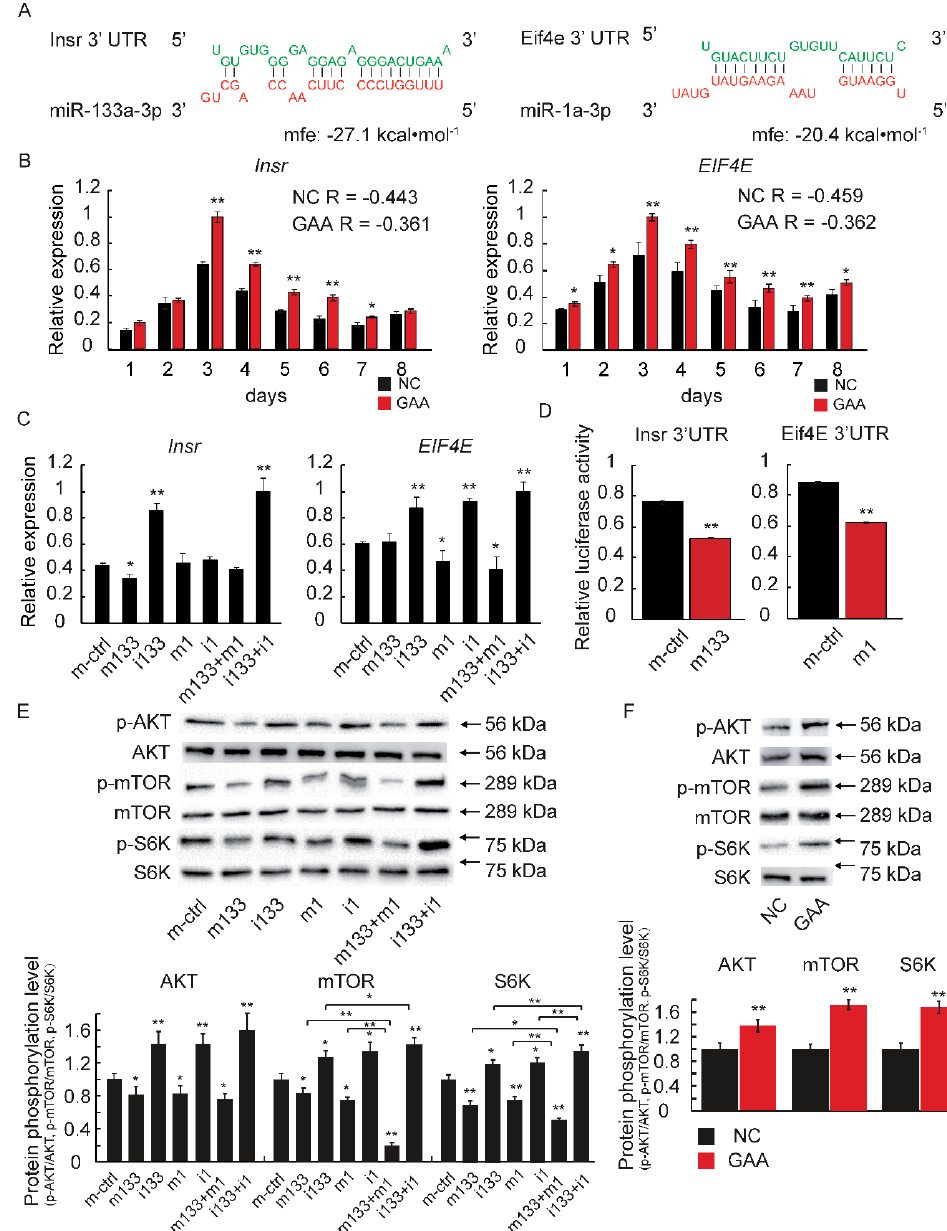
Figure 6. The downregulation of miR-133a-3p and miR-1a-3p promotes skeletal muscle growth by activating Akt/mTOR signaling. ( A ) Potential binding sites for miR-133a-3p and miR-1a-3p in the 3 ′ UTR of Insr and EIF4E mRNA, respectively, predicted by RNAhybrid (MFE: minimal free energy); ( B ) the relative expression of the miRNA target gene after GAA treatment or miRNA mimic overexpression (Student’s t -test) (R: Pearson correlation coefficient); ( C ) the relative expression of the miRNA target gene after miRNA mimic overexpression (Tukey’s post-hoc test); ( D ) luciferase reporter assay indicated that transfection with miRNA mimic significantly suppressed the relative activity of luciferase (Student’s t -test); ( E , F ) the Akt, mTOR and S6K phosphorylation levels detected by western blotting after the overexpression of miRNA mimic or GAA treatment (Tukey’s post-hoc test). The results are expressed as mean ± S.D. of three independent experiments. * p < 0.05; ** p < 0.01 compared with negative control (on the bars) or mimic control (on the bars) or between the indicated groups.